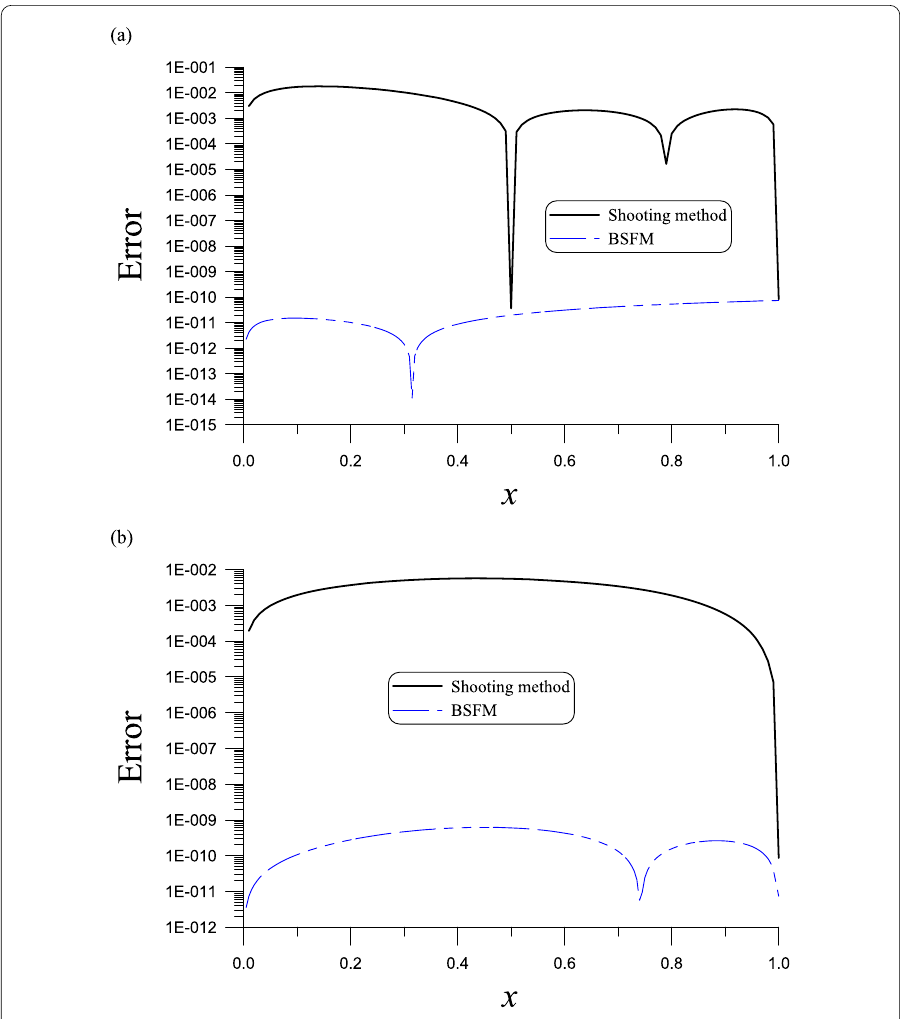
Figure 5 Comparing the numerical errors obtained by the shooting method and the BSFM for ( a ) Example 3 and ( b ) Example